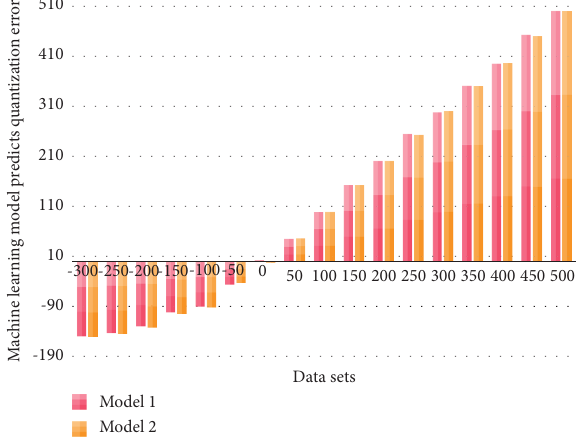
Figure 7: Comparison of prediction and quantization errors of machine learning models.